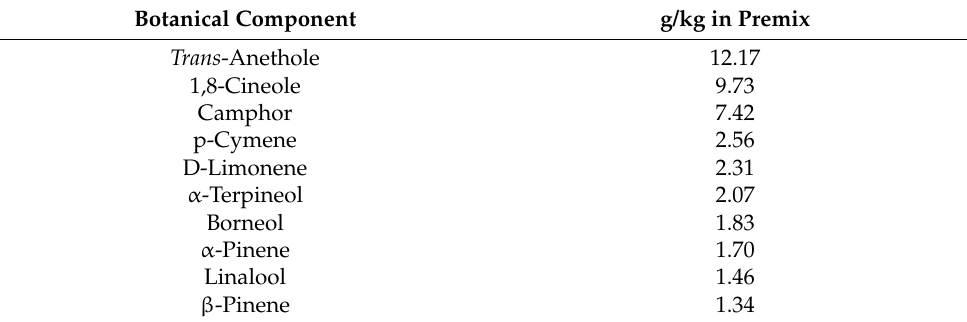
Table 2. Botanical composition of supplemented EO in the BBC 1